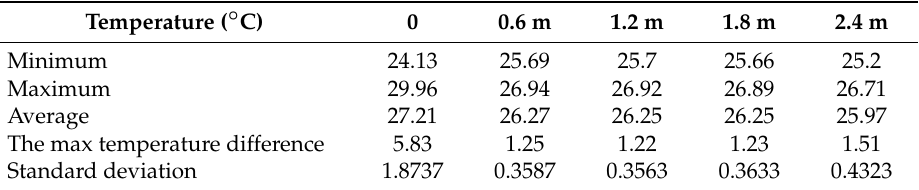
Table 1. Results of 125 temperature measurement